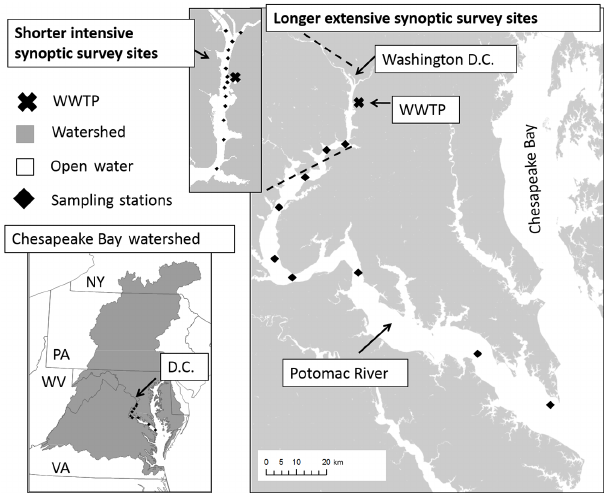
Figure 1. Map showing the Potomac River sampling stations (black diamond) and the location of the Blue Plains Wastewater Treatment plant (WWTP, black X) just south of Washington D.C., within the Chesapeake Bay watershed. The larger figure shows the location of monthly extensive synoptic surveys sites and the smaller panel on upper left shows the locations of the shorter intensive synoptic surveys. The larger panel also shows the location for the historical Maryland DNR surface water sampling